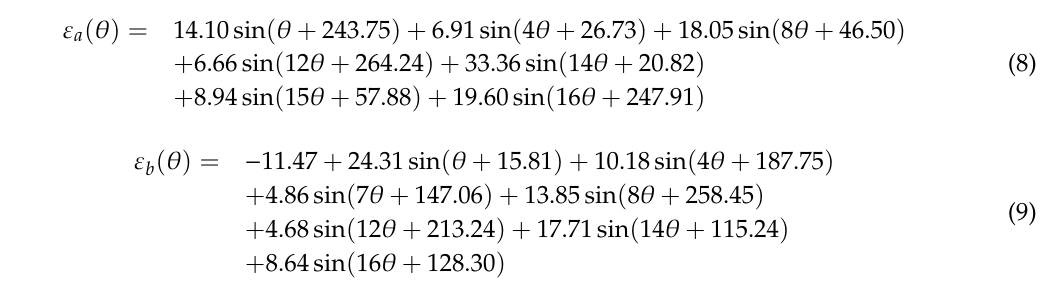
Figure 7. Phase range of harmonics in each order of angle error of joint modules: ( a ) joint module a; ( b ) joint module b.